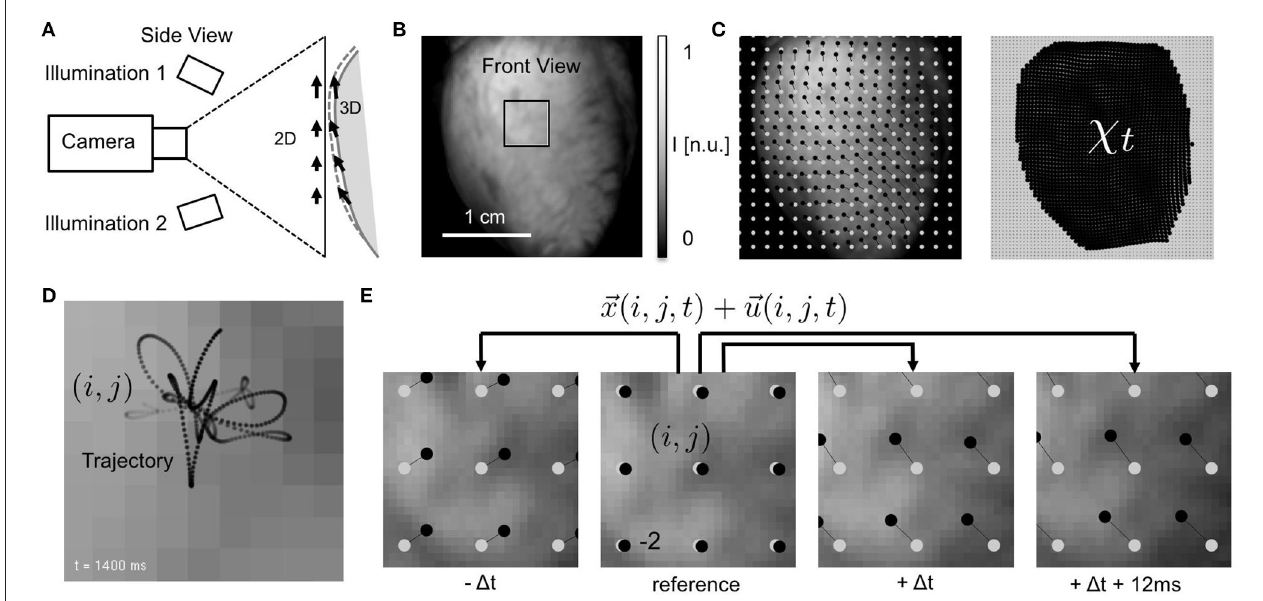
FIGURE 1 | Electromechanical optical mapping with beating, strongly deforming and fluorescing hearts. (A) Schematic drawing of experimental setup with single high-speed camera filming ventricular surface of rabbit heart (side view). Tracking of motion is possible only within the image plane (2D). (B) Raw video image (128 × 128 pixels) showing heart surface during optical mapping with voltage-sensitive staining (front view). ROI see (E) . (C) Tracked displacements and mechanical configuration χ t at time t (left: every 8 th vector, right: every 2 nd vector). Points (black) indicating displacements of single tissue segment with respect to reference position (gray). See also Supplementary Video 1 . (D) Trajectory of tracked tissue segment moving during ventricular fibrillation through pixel plane. Motion amplitudes are in the order of a few pixels (maximal 3–4 pixels from initial position, 2 ms temporal resolution). (E) Tracking of tissue movements during pacing with displacement amplitudes in the order of |E u | ≈ 10.0 pixels. Points (black) indicating movements of single tissue segment ( i , j ) with respect to reference position (gray) in reference video image I r (shown is every 10 th segment or vector for illustration